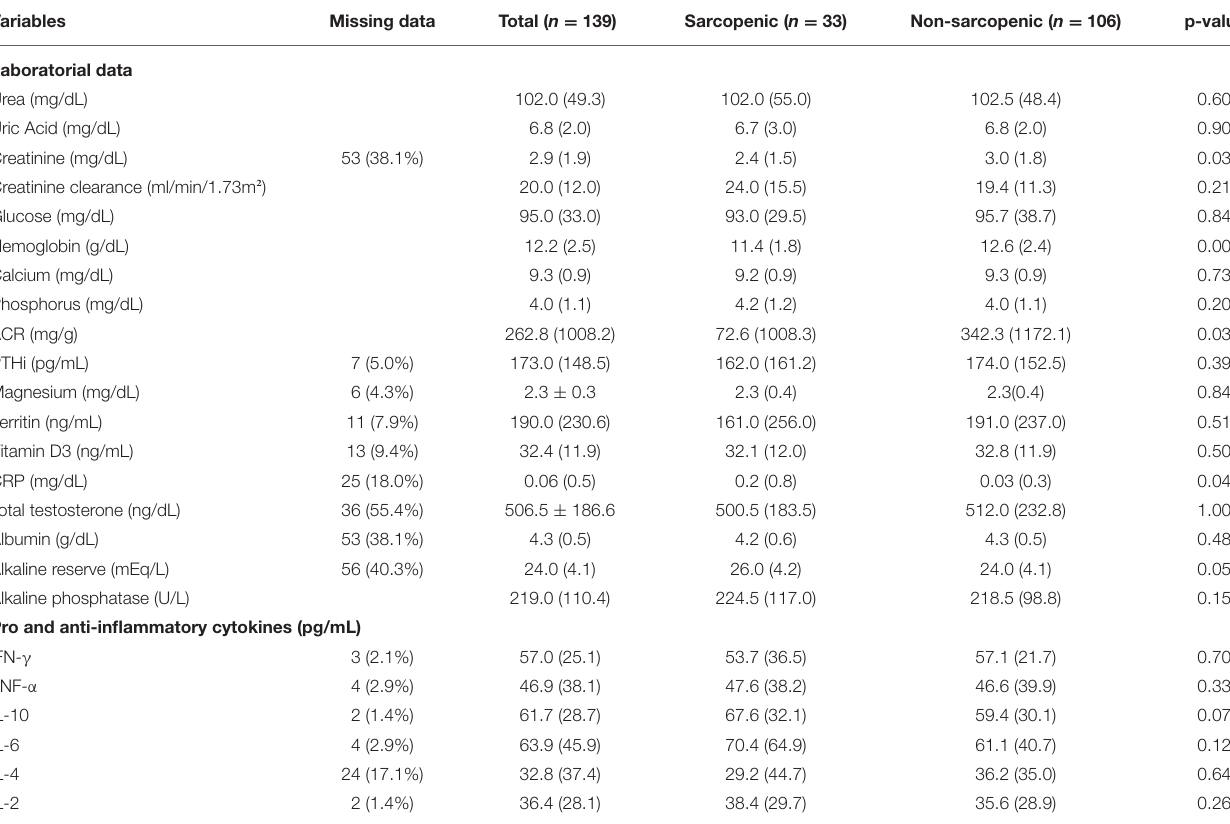
TABLE 2 | Distribution of sarcopenia according to biochemical parameters and inflammatory markers in the CKD study population.